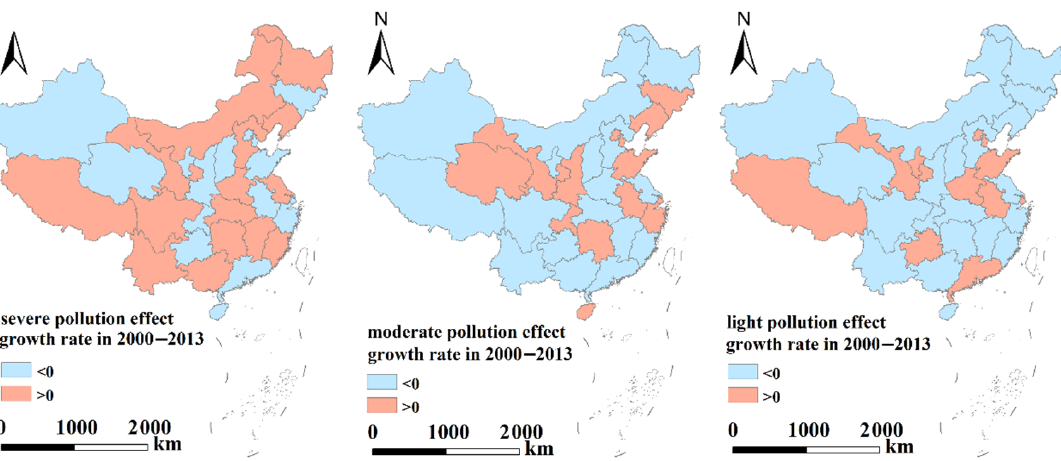
Figure 3. Transboundary pollution effects at the provincial level (three types of polluting enterprises).